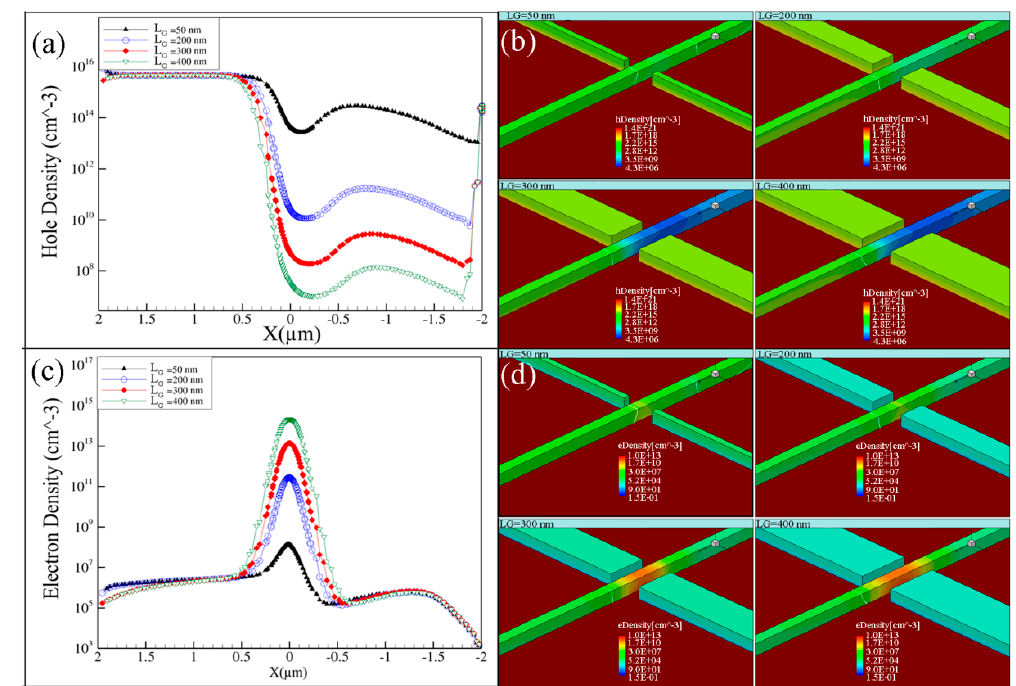
Figure 5. ( a ) Holes distribution along the channel for the devices with four different L G s at the cutline of Z = 50 nm, ( b ) the corresponding side views of the holes ( c ) electrons distribution along the channel for the same devices with four L G s at a cutline at Z = 50 nm, and ( d ) the corresponding side view of the electron distribution.